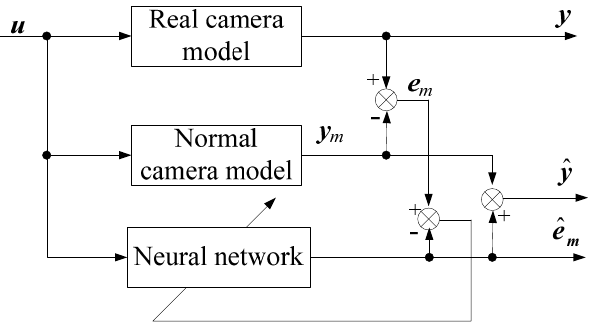
Figure 7. Structure of the proposed calibration method.